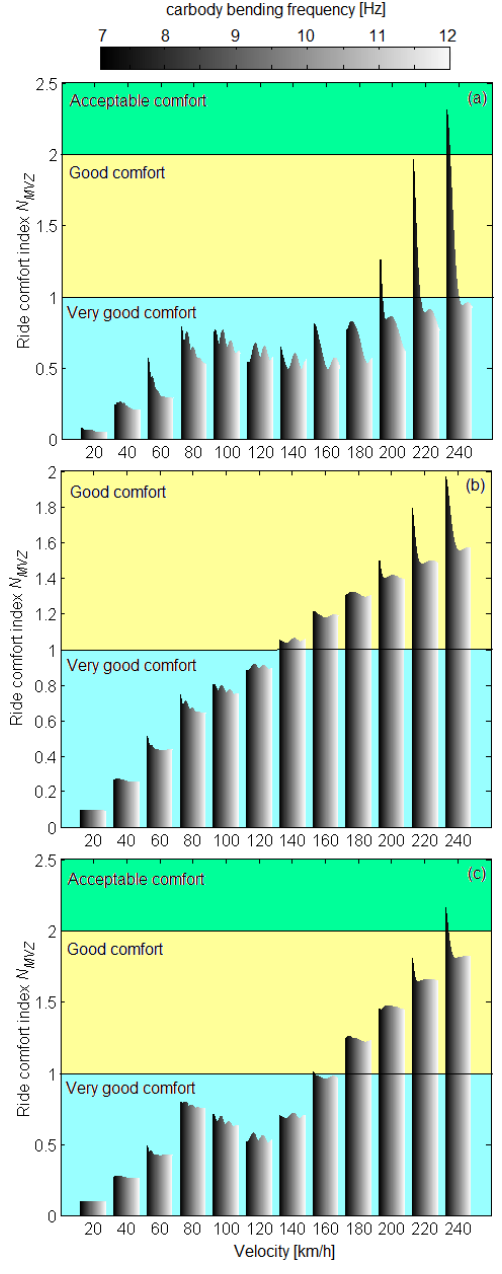
Figure 13. Ride comfort index N MVZ depending on the carbody bending frequency: ( a ) in point C ; ( b ) in point B 1 ; ( c ) in point B 2 .